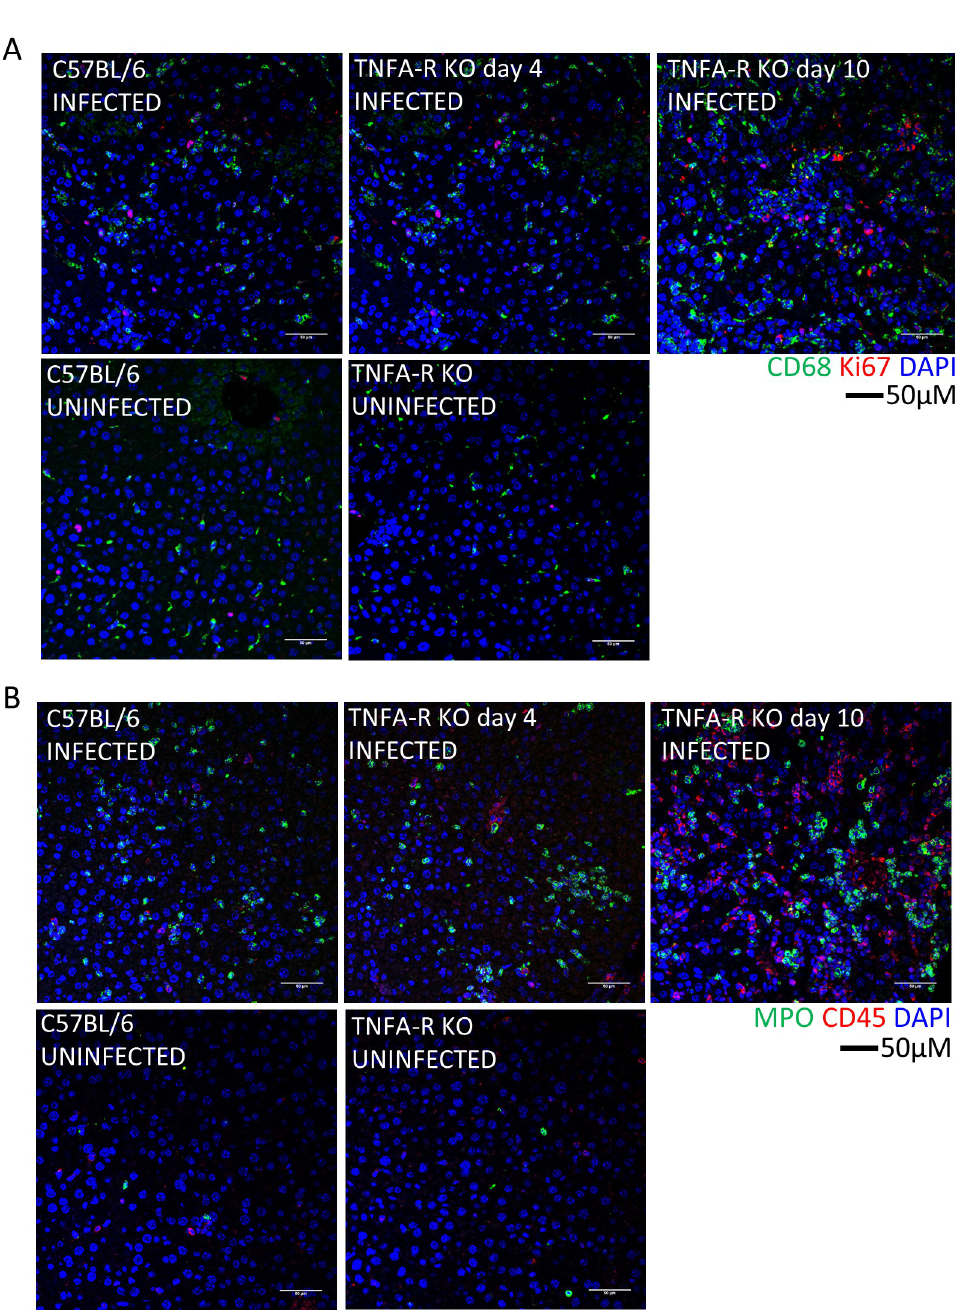
Fig 6. Immune cells in the livers of WT and TNFA-R KO mice. Representative IFA demonstrates presence of CD68 + macrophages (A, green) and Ki67 + proliferating cells (A, red) or MPO (B, green), and CD45 + leukocytes (B, red) in livers of infected animals compared to uninfected at the indicated time points. Nuclei are stained with DAPI